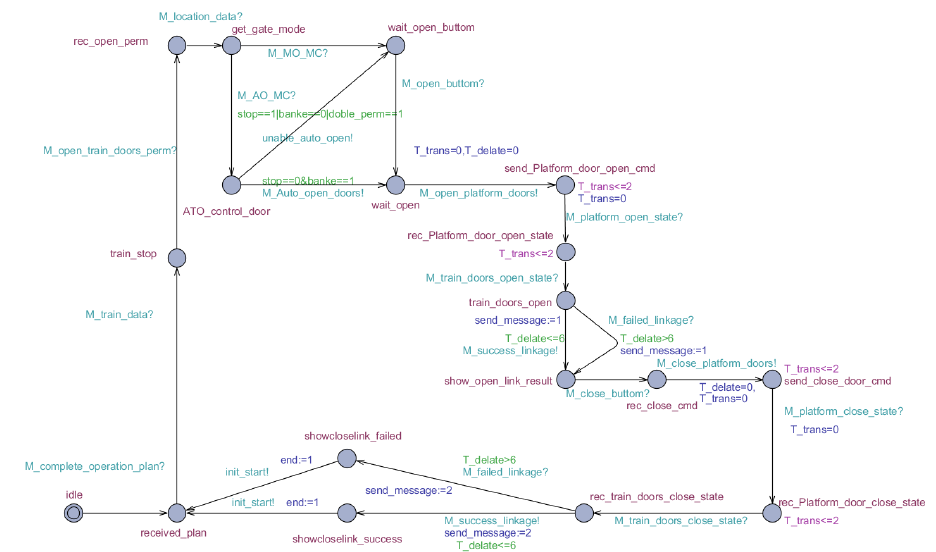
Figure 14. The ATO model of the linkage control scenario of train doors and platform